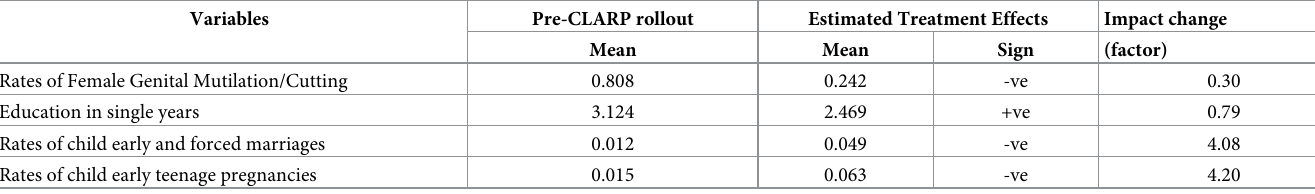
Table 3. Summary of difference-in-difference regression results.